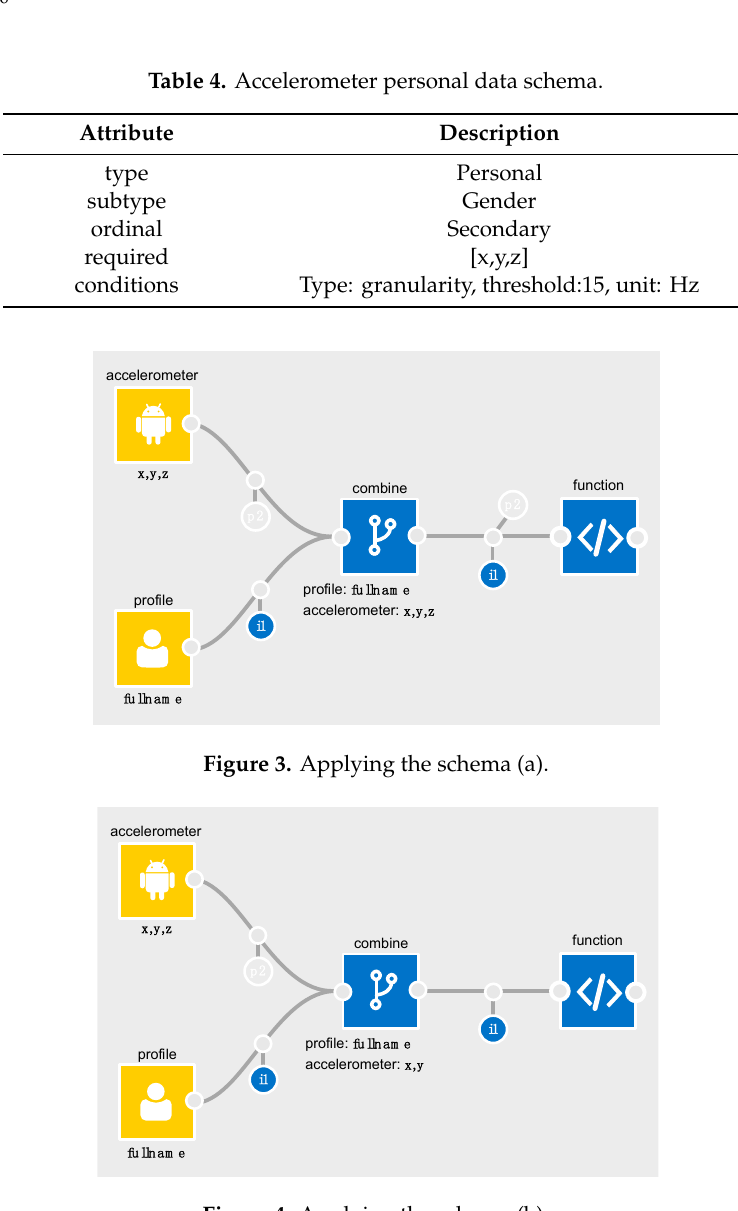
Figure 4. Applying the schema (b).